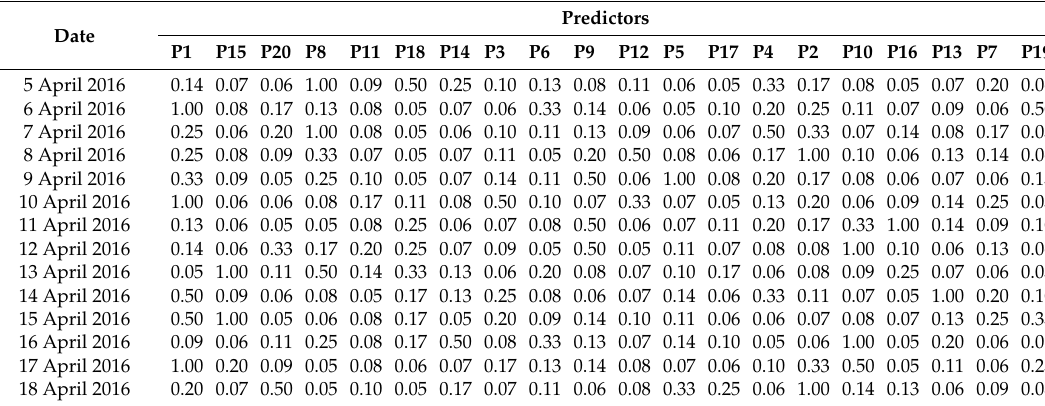
Table 2. Weights w i , D of the PPFMCP model 2 for the predictors P1 to